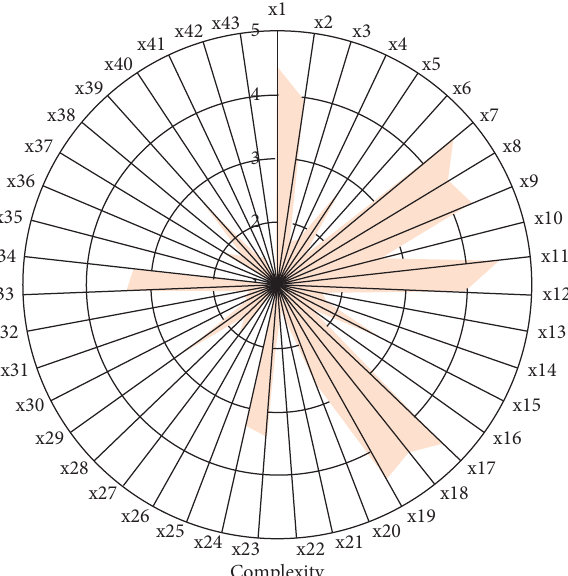
Figure 5: Complexity evaluation of 43 semiprecast